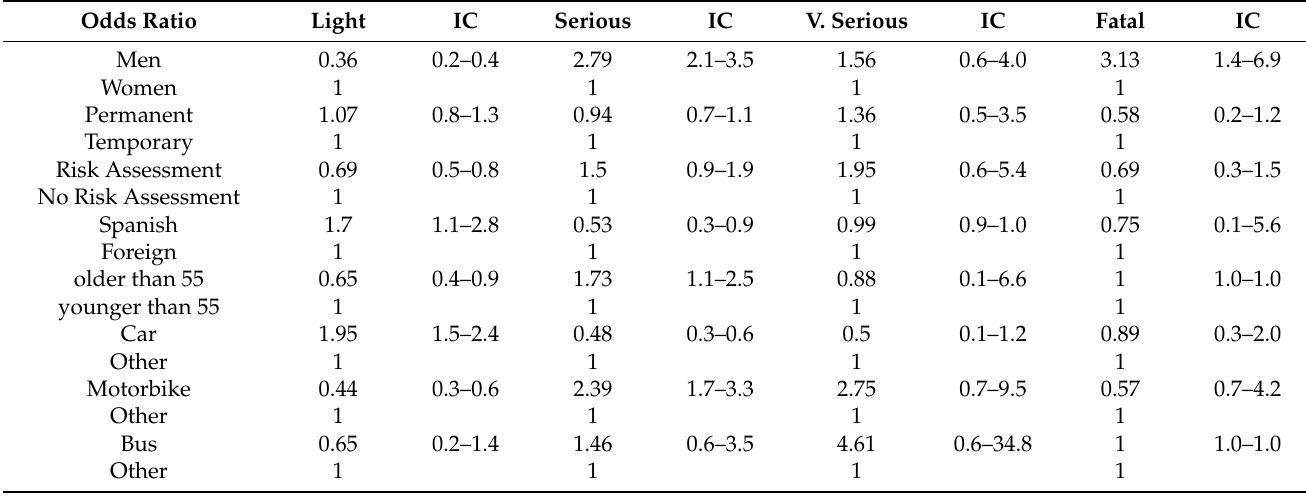
Table 1. Odds ratio calculated for occupational traffic accident